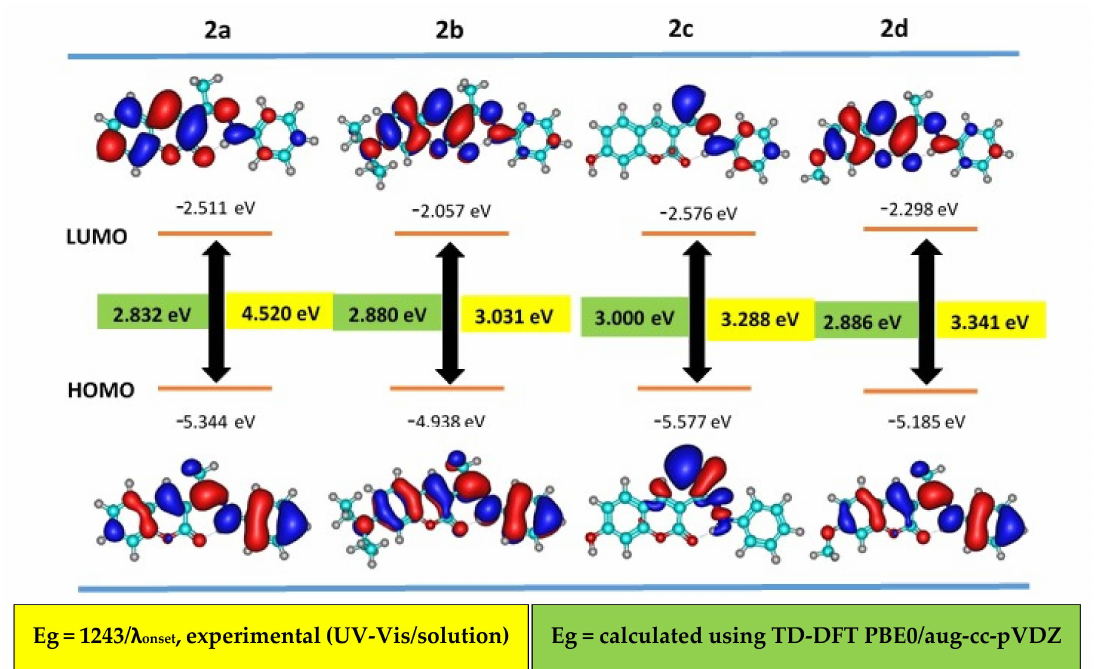
Figure 6. Frontier molecular orbitals corresponding to the optimized structures of compounds 2a – d